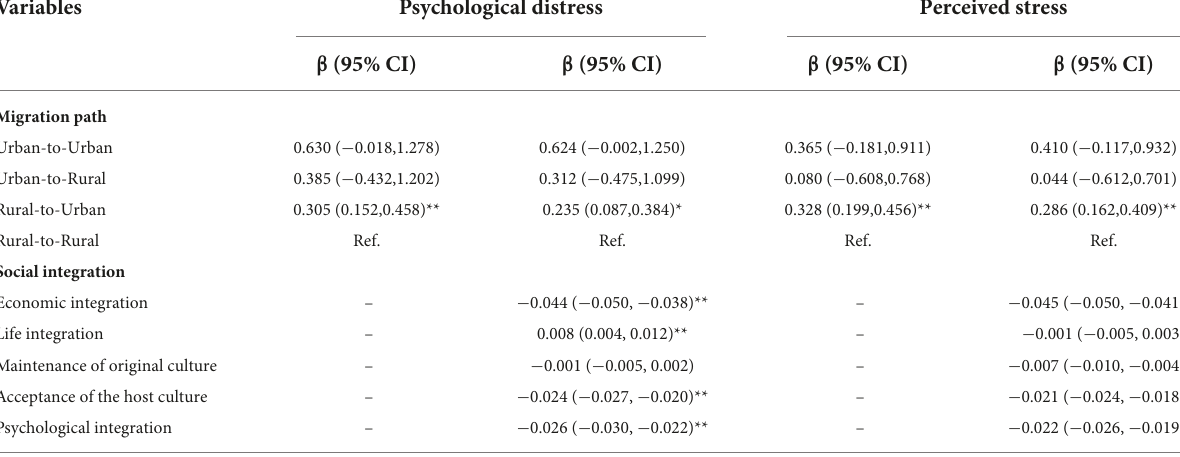
TABLE 2 The relationship between migration paths, social integration and the mental health of new-generation migrants with multiple linear regression.